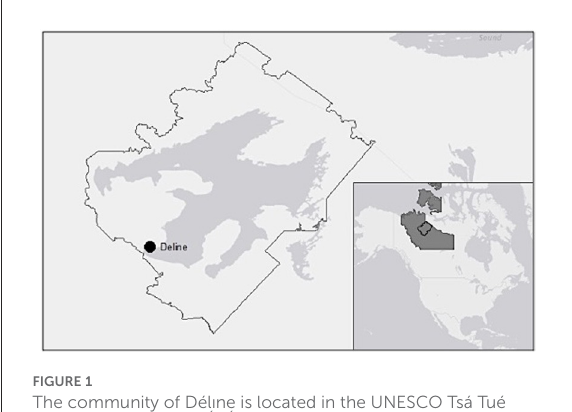
FIGURE1 The community of Délı˛ne˛ is located in the UNESCO Tsá Tué Biosphere Reserve, which encompasses the watershed of Great Bear Lake in Northwest Territories,